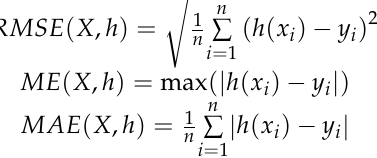
Figure 13. ( a ) Platform schematic; ( b ) Subsidence simulation experiment; ( c ) Surface in 3D laser scanner ( d ) Reconstructed surface. We construct three different surface shapes for reconstruction accuracy analysis, where the evaluation indicators are root mean square error (RMSE), maximum decision error (ME) and mean absolute error (MAE). Their definitions are as follows: